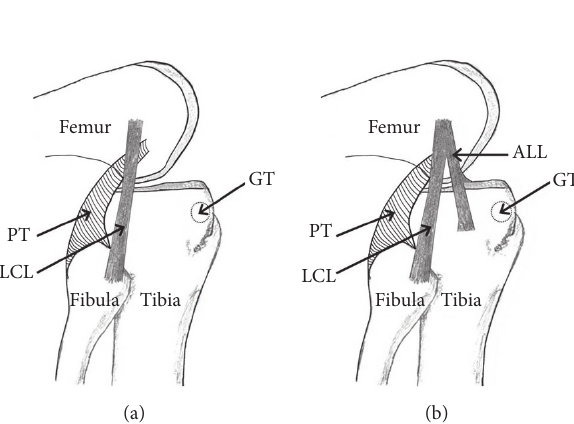
Histological analysis using Masson’s trichrome stained sections revealed that the ligament has dense connective tissue in the form of collagen bundles with fibroblasts and vascular tissue in it (Figures 3A–3D).